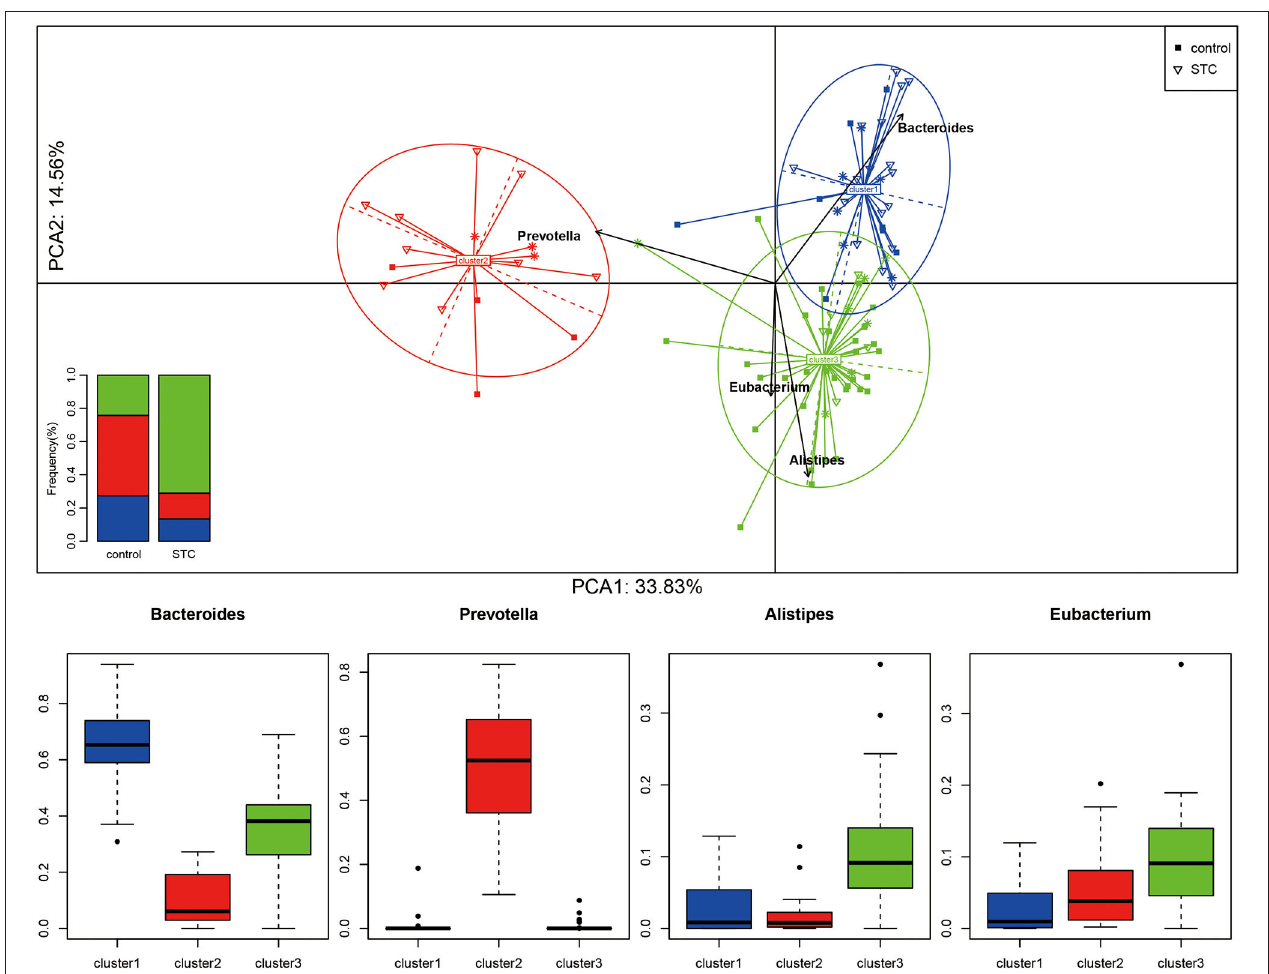
FIGURE 2 | Sample clustering and classification for Enterotype analysis. According to the Jensen–Shannon distance of genus level, all the samples are clustered into the 3 types by the method of Manimozhiyan. Each of these 3 clusters are identifiable by the variation in the levels of 1 of 3 genera: Bacteroides (cluster 1), Prevotella (cluster 2), Alistipes and Ruminococcus (cluster 3). The histogram shows the distribution ratio of the control and STC groups in the 3 clusters.